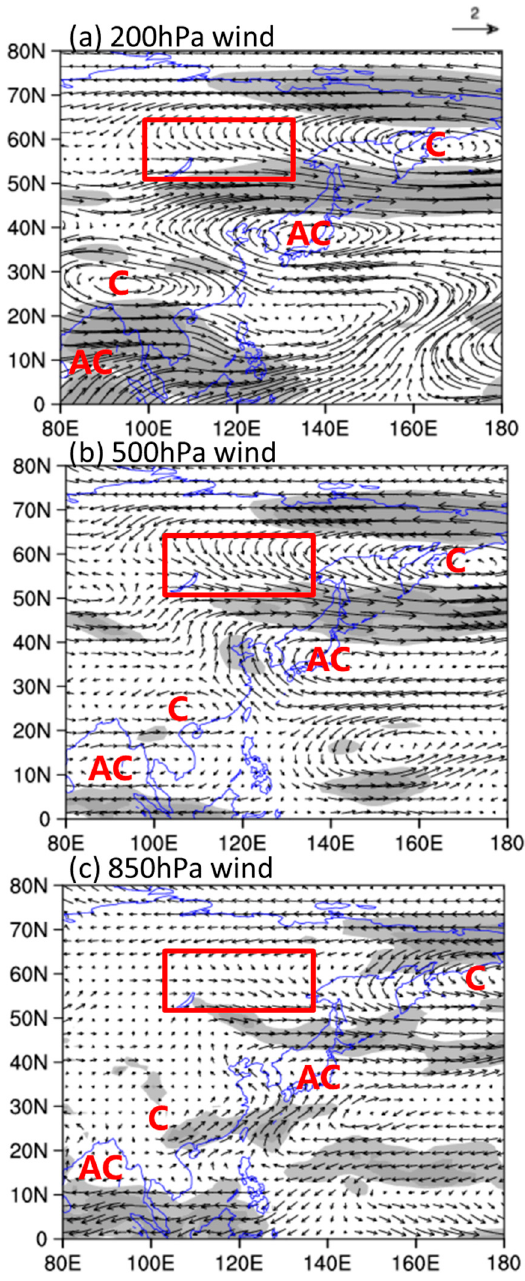
Figure 8. Composite anomalies of spring atmospheric circulation (unit: m/s) at ( a ) 200 hPa; ( b ) 500 hPa; and ( c ) 850 hPa in the EP El Niño years. East Russia is in the red box. Shading areas have the anomalies being statistically significant at the 0.1 level (i.e., p < 0.1) estimated by a local Student’s t test.